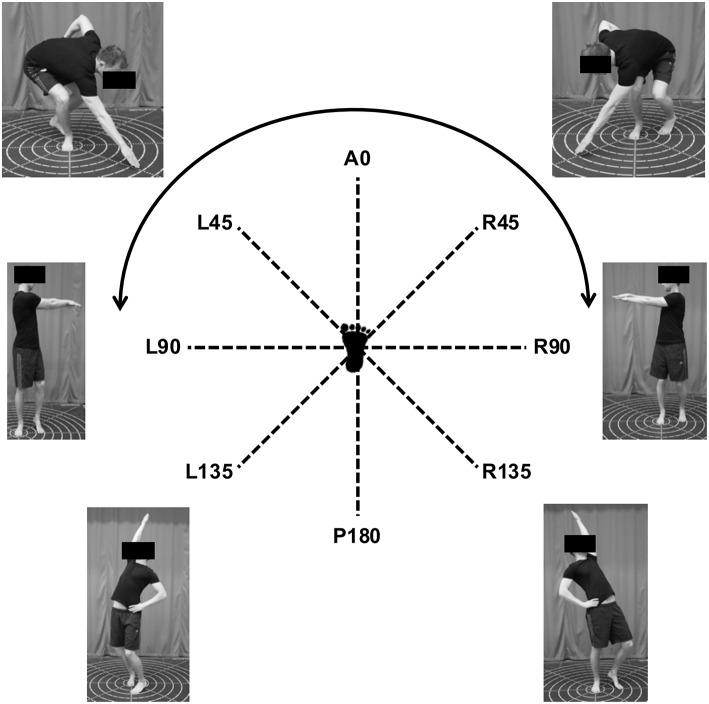
Maximum reach position of HSEBT reaches standing on the right foot.